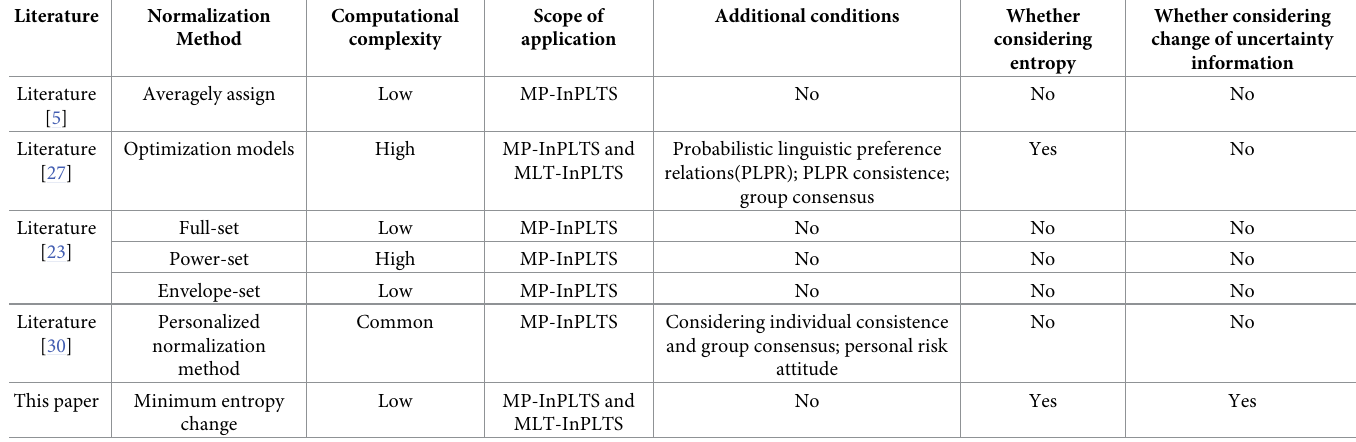
Table 7. The comparison with different normalization methods of